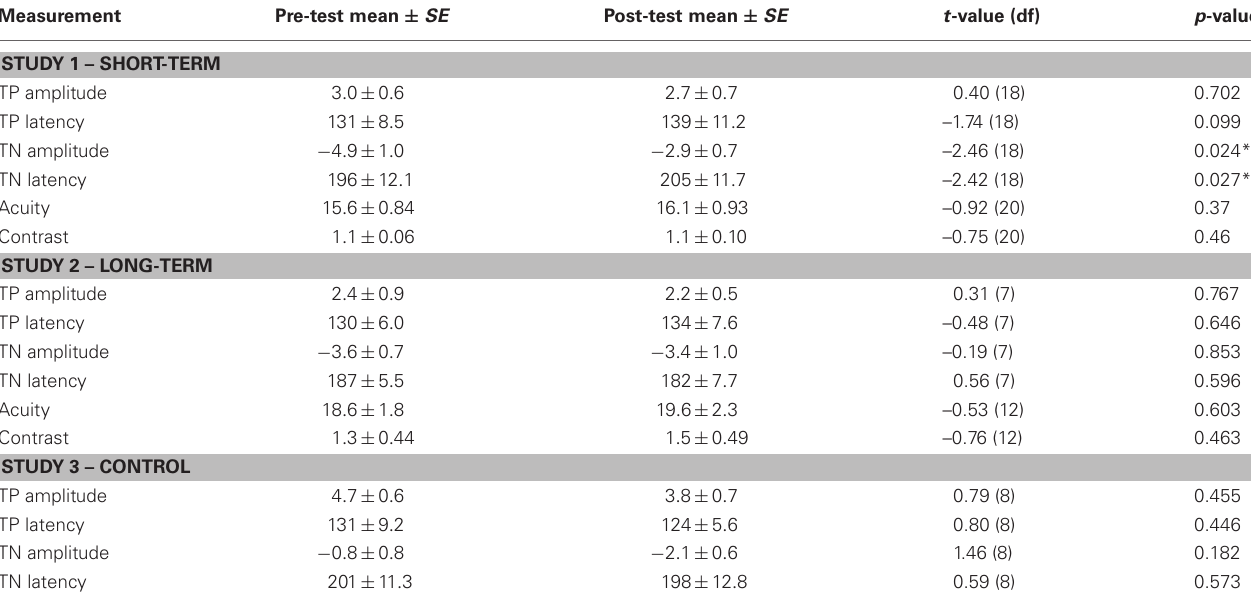
Table 1 | Overview of EEG and psychophysical results of study 1, 2, and